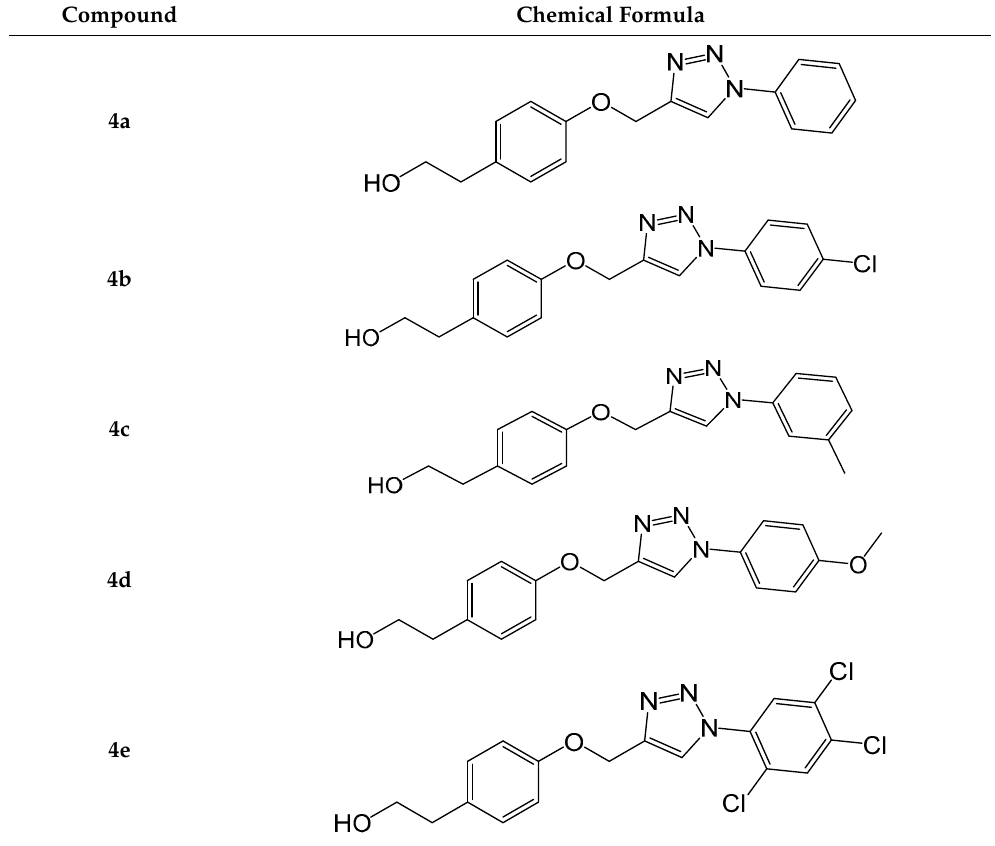
Table 2. Cont. Compound Chemical